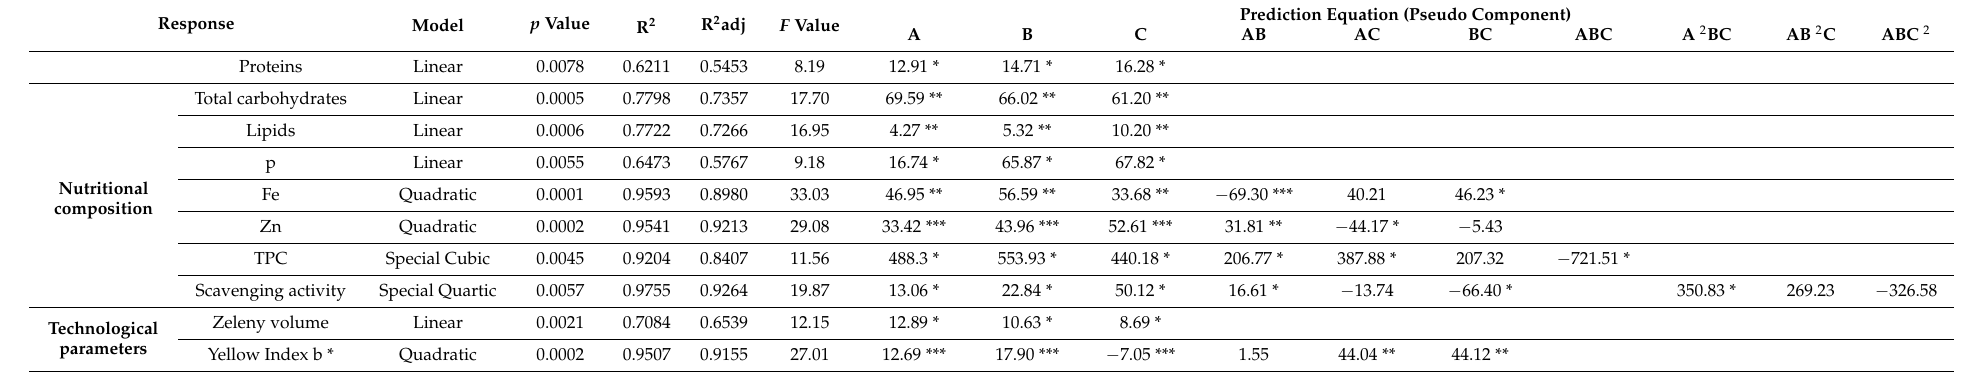
Table 1. Analysis of the predicted model equations for nutritional and technological quality parameters of wheat–chickpea–milk powder composite flour. Response